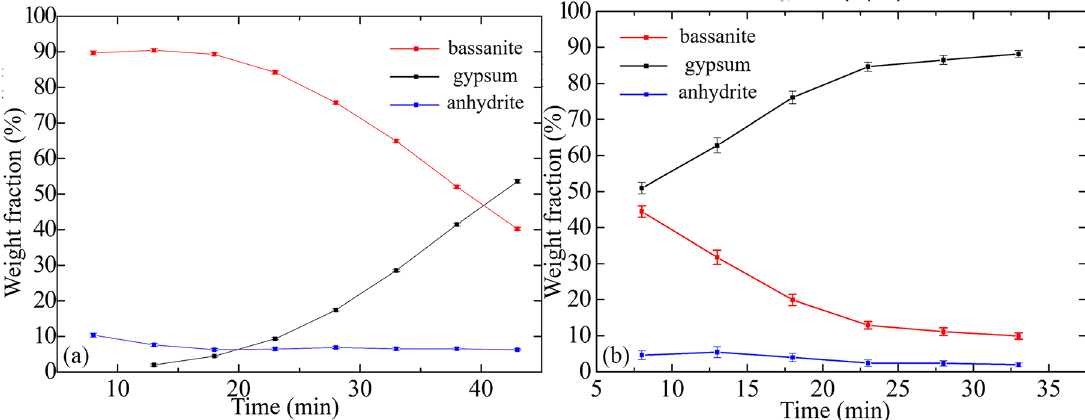
Figure 15. Mass fractions of the sulfate-based compounds (anhydrite - blue dots, bassanite - red dots, and gypsum - black dots) as a function of the hydration time of the samples (a) CP2 and (b) RP2 obtained by the parametric Rietveld refinement.